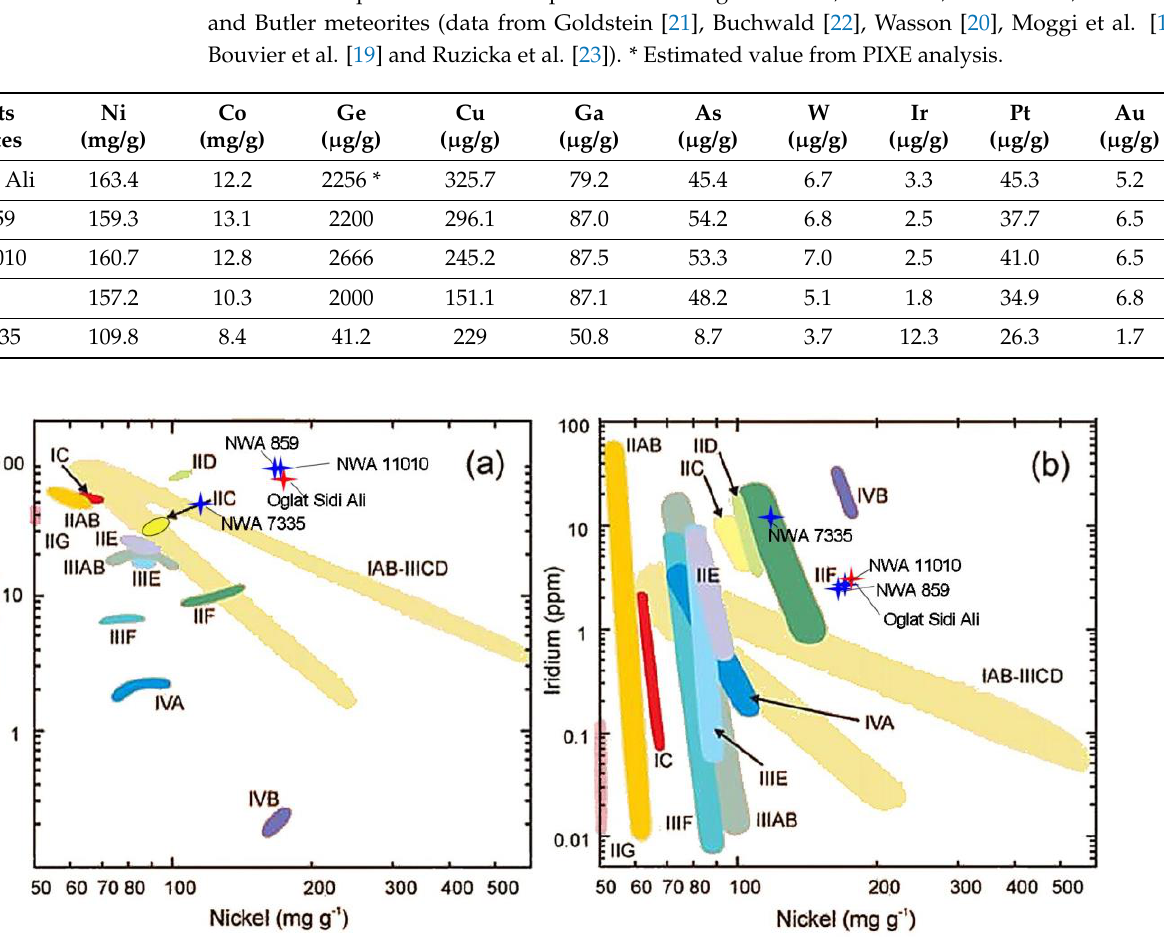
Table 4. Siderophile elements composition of the Oglat Sidi Ali, NWA 859, NWA 11010, NWA 7335 and Butler meteorites (data from Goldstein [21], Buchwald [22], Wasson [20], Moggi et al. [18], Bou- vier et al. [19] and Ruzicka et al. [23]). * Estimated value from PIXE analysis.